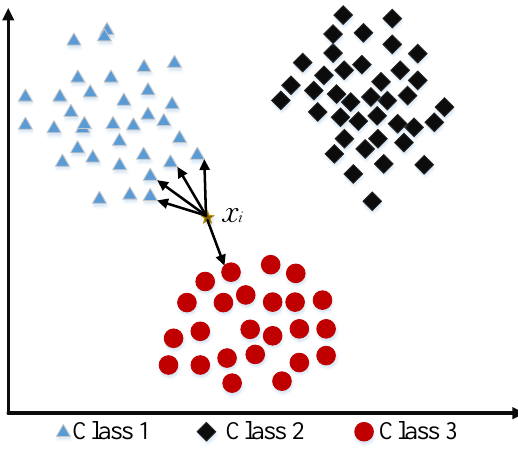
Figure 11. A architecture of k-nearest Neighbor (KNN) model for the 2D data set and three